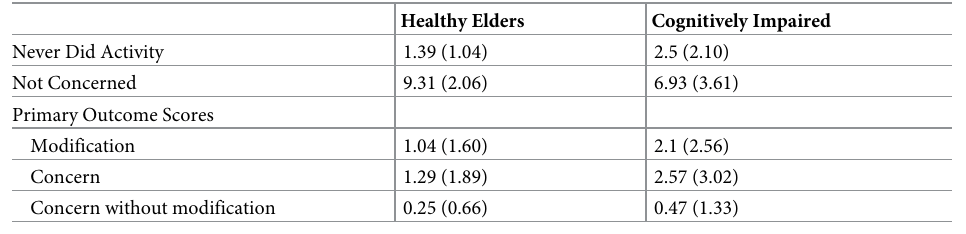
Table 3. Mean scores on the Activity Modification scale.